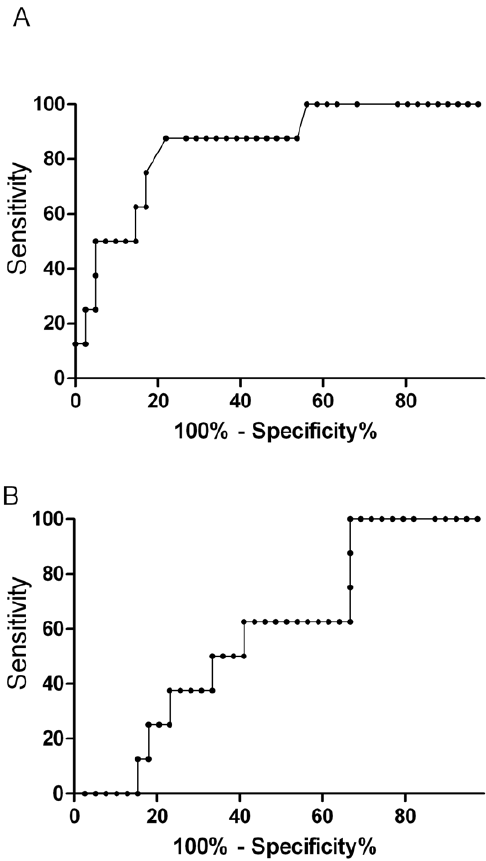
Figure 2. Top panel is the nonparametric receiver operating curve (ROC) assessing asymmetrical dimethylarginine (AUROC, 0.85; 95%CI 0.71–0.99) and the bottom panel venous lactate (AUROC 0.63; 95%CI 0.41–0.83) as prognostic markers for mortality in severe malaria (p=0.003).